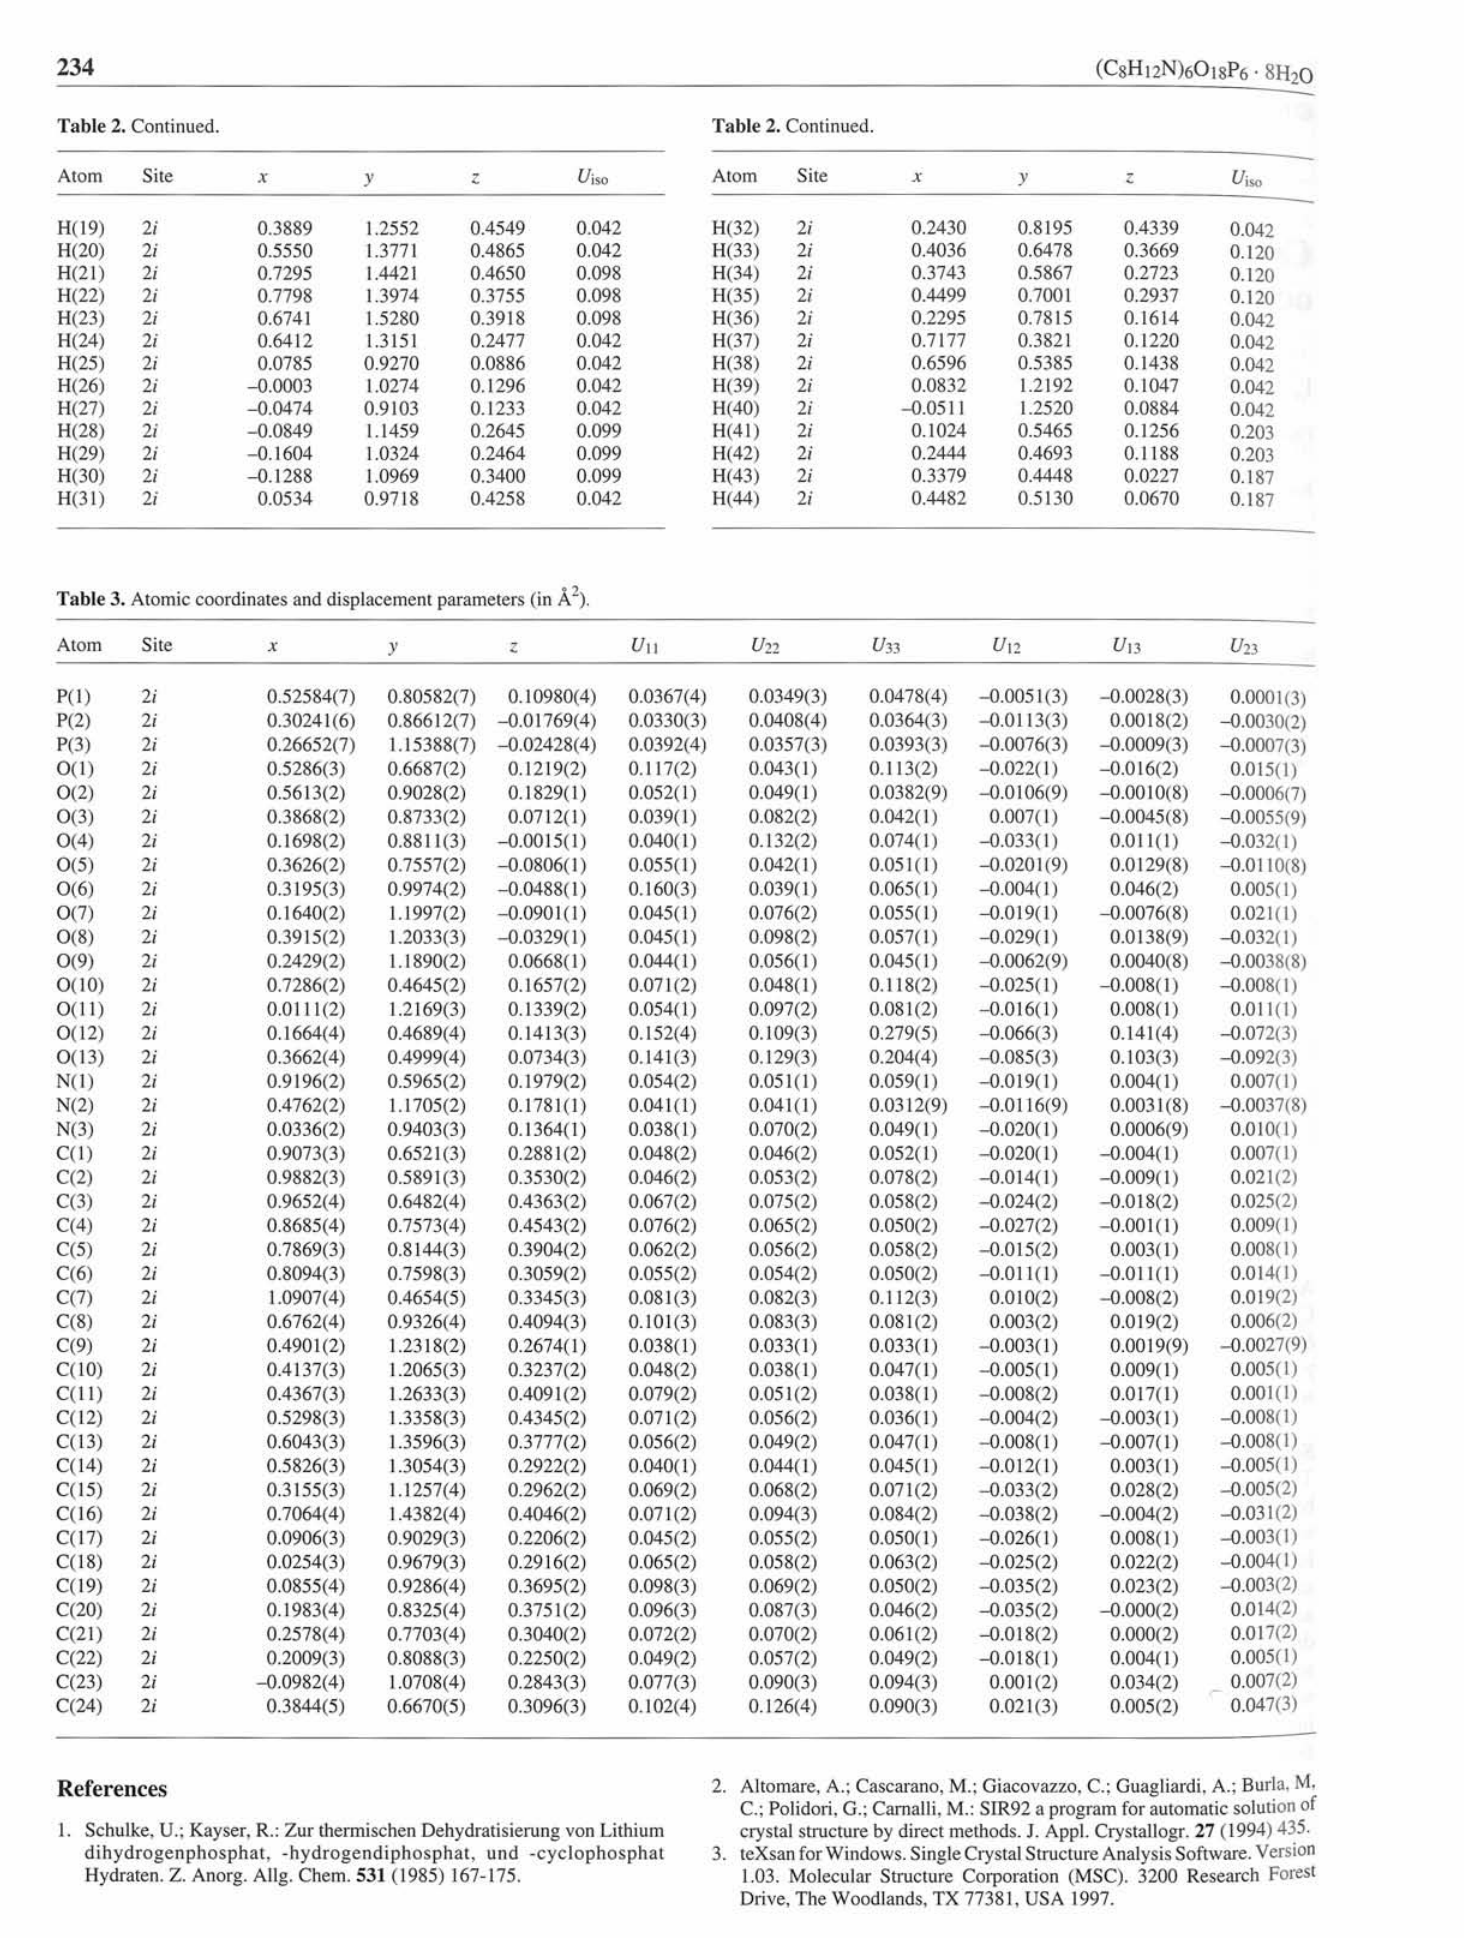
Table 3. Atomic coordinates and displacement parameters (in Â 2